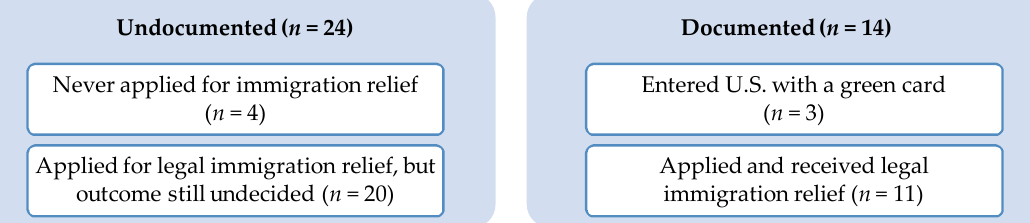
Figure 1. Current Documentation Status among Immigrant Latina Transgender Women ( n = 38) in the STROBE Study, Washington, DC, USA, 2017.